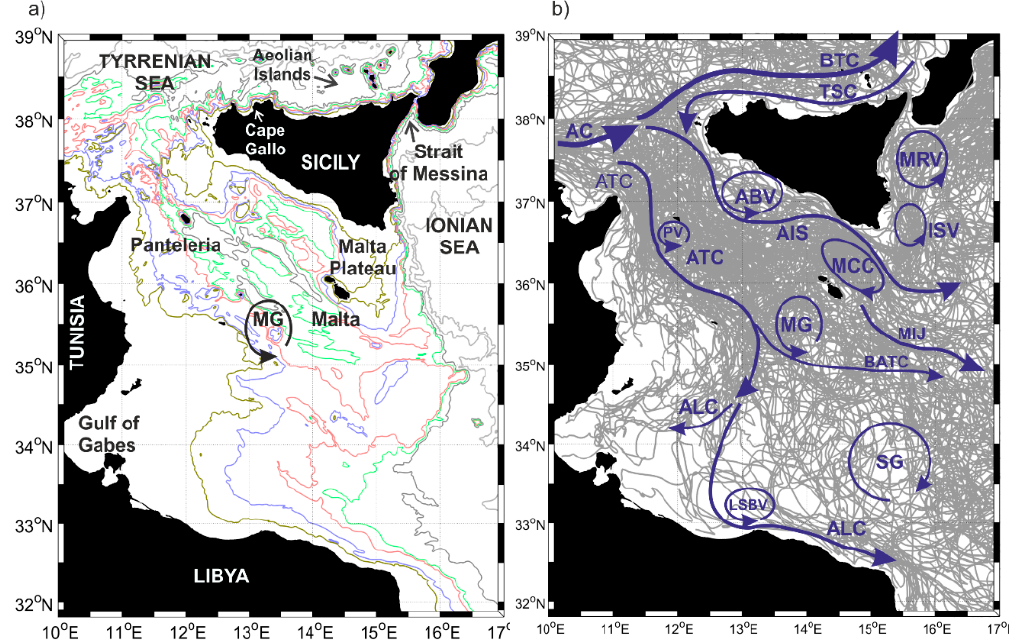
Figure 1. ( a ) Bathymetry of the SC (100 m, 200 m, 400 m, 600 m, 1000 m, 2000 m isobaths) and geographical references. ( b ) Low-pass filtered drifter trajectories in the SC between 1993 and 2018, superimposed with the schematic surface circulation adapted from [1,3]. Acronyms are listed in Table 1.